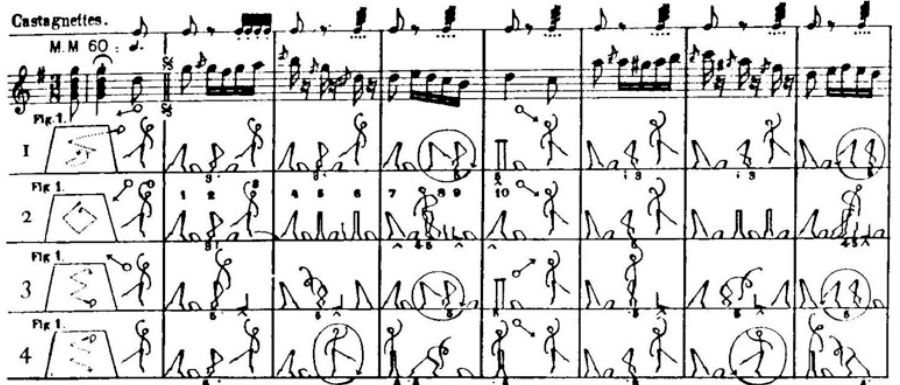
Figure 3. Excerpt from the Cachucha in Friedrich Albert Zorn, Grammar of the Art of Dancing. Boston: Heintzemann Press, 1905.